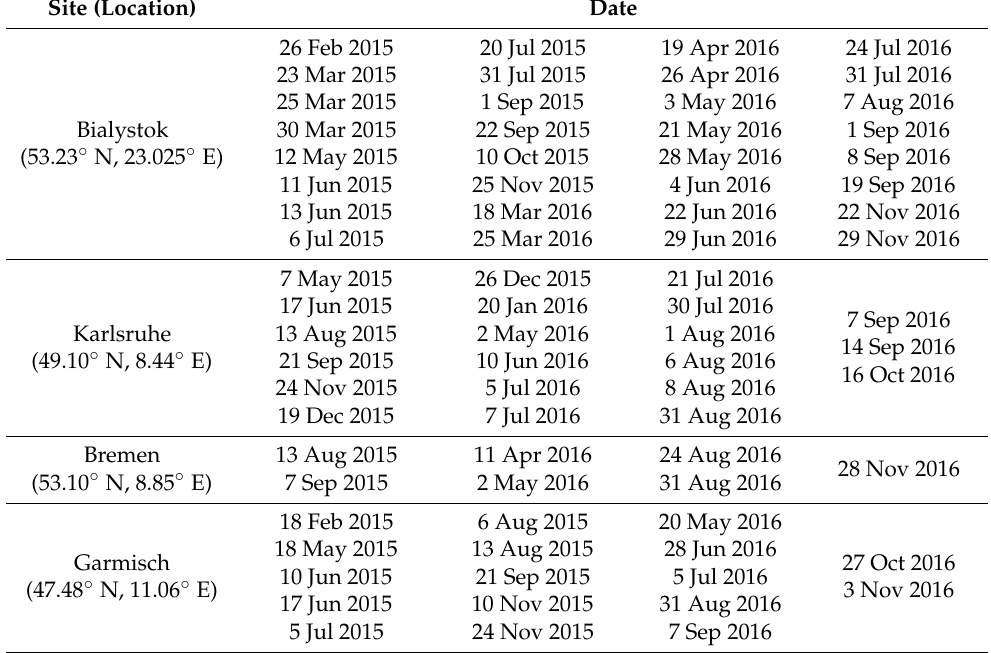
Table A1. Summary of the available dates of different sites used for correlation analysis.